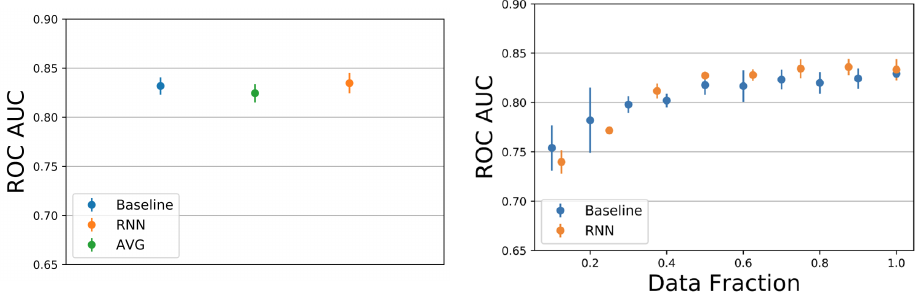
Figure 5: Left panel: 3-folded ROC AUC for the discrimination of "ACDC withouth modi- fication" vs. other actions for the three models. Right panel: ROC AUC as a function of the training data for the baseline model and the RNN